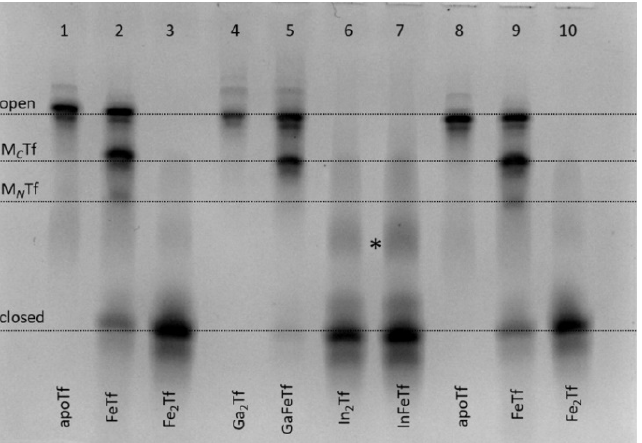
Figure 3. Urea-PAGE of purified Ga(III)-Tf (lanes 4 and 5) and In(III)-Tf (lanes 6 and 7) in comparison with control samples (apoTf, lanes 1 and 8; FeTf, lanes 2 and 9; and Fe 2 Tf, lanes 3 and 10). See Materials and Methods for sample preparation. All samples were diluted to ~5 μM Tf with the binding buffer (20 mM HEPES, 25 mM NaHCO 3 , 140 mM NaCl, pH 7.4) [3] before loading into the gel. Four main Tf conformations (Figure 1) are marked (M C Tf and M N Tf contain one metal ion bound to C -lobes or N -lobes, respectively). A possible additional band for In(III)-Tf is marked with an aster- isk.